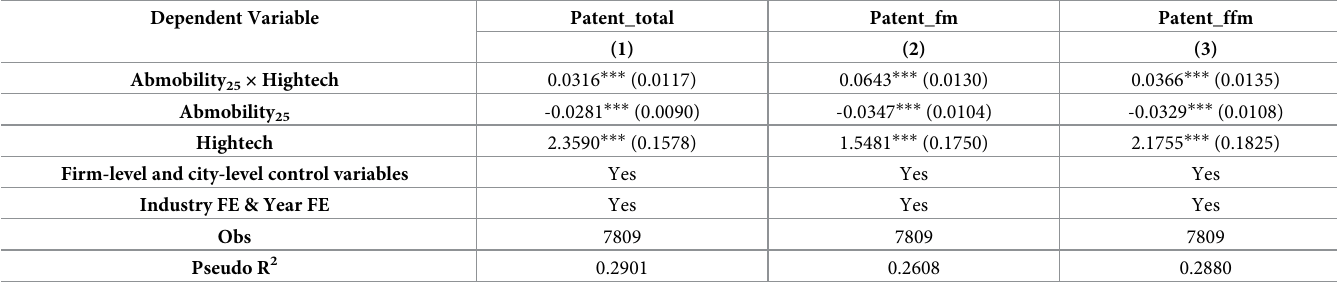
Table 9. Heterogeneity test of industry.